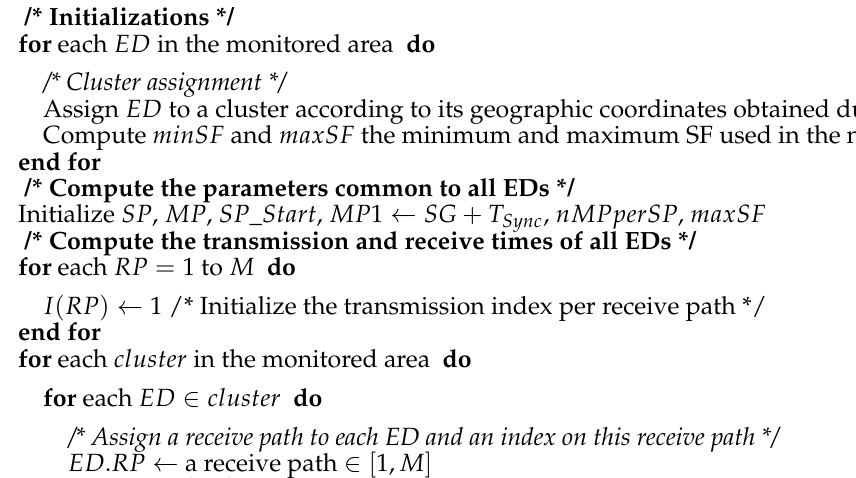
Algorithm 1 End Devices Configuration (Run by the server to configure all End